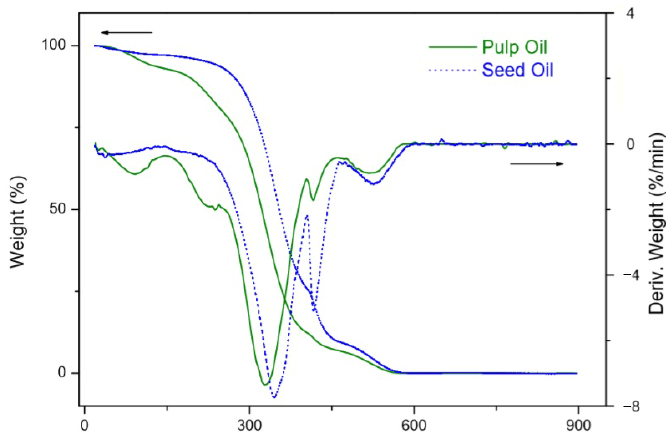
Figure 1. Thermal stability canjiqueira pulp and seed oils.